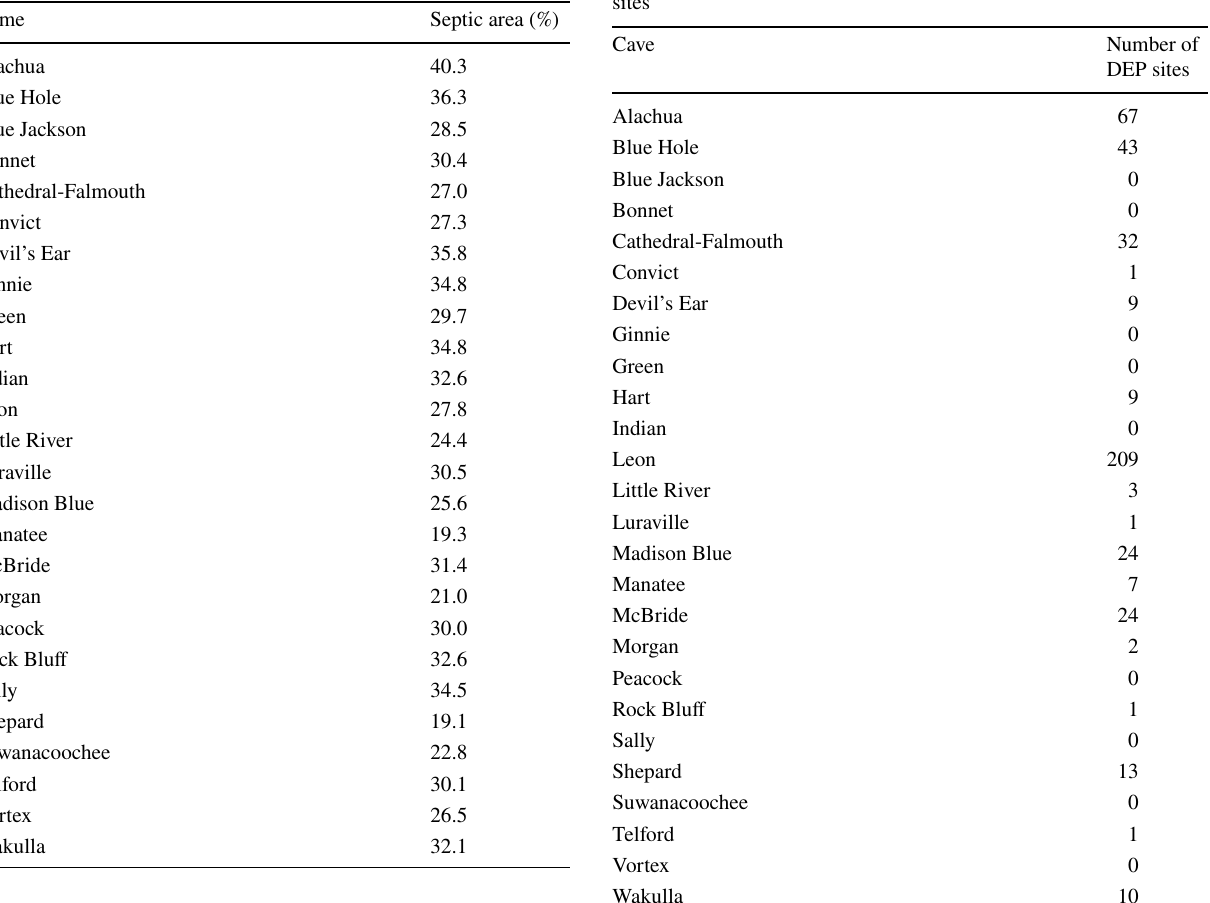
Table 5 Percentages of septic systems Table 6 Cave/spring systems and the number of closest DEP